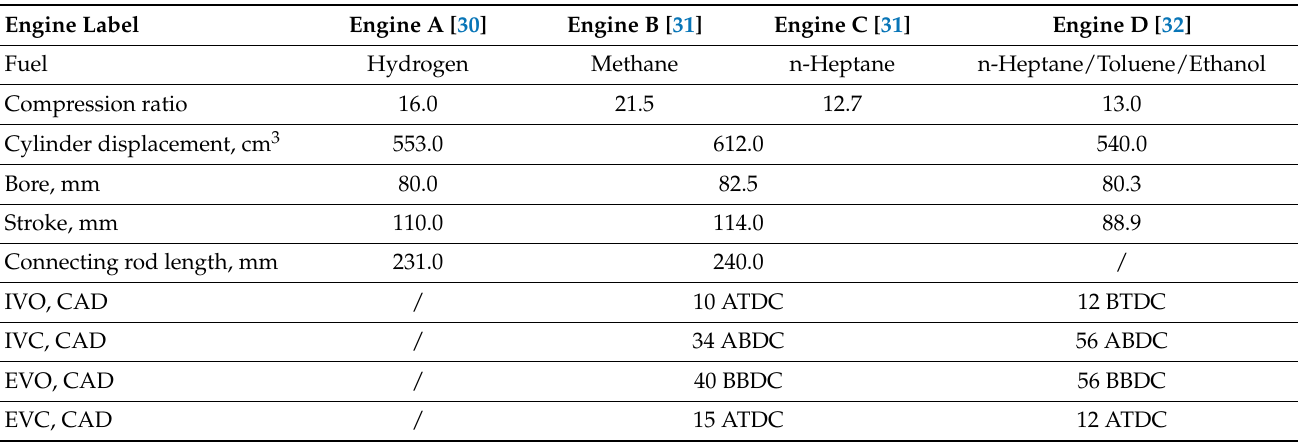
Table 1. Main engines’ characteristics.